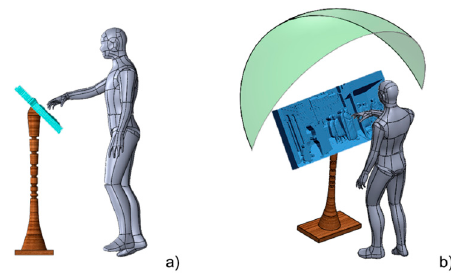
Figure 7. ( a ) CAD model of the bas-relief and the user; ( b ) CAD model of the plausible region (green) to host the Kinect ®